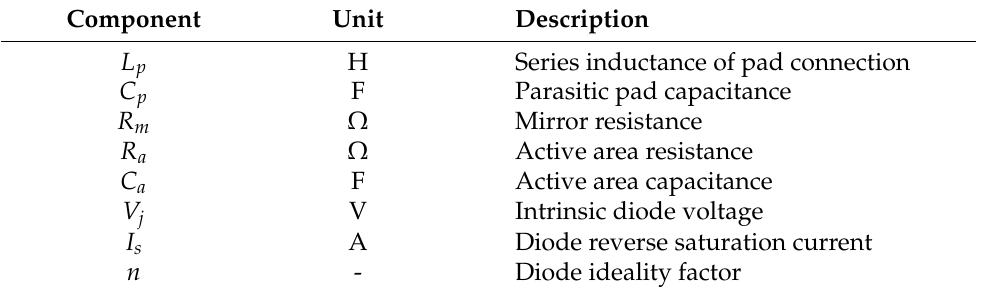
Figure 4. VCSEL equivalent circuit [13]. Table 1. Components of electronic